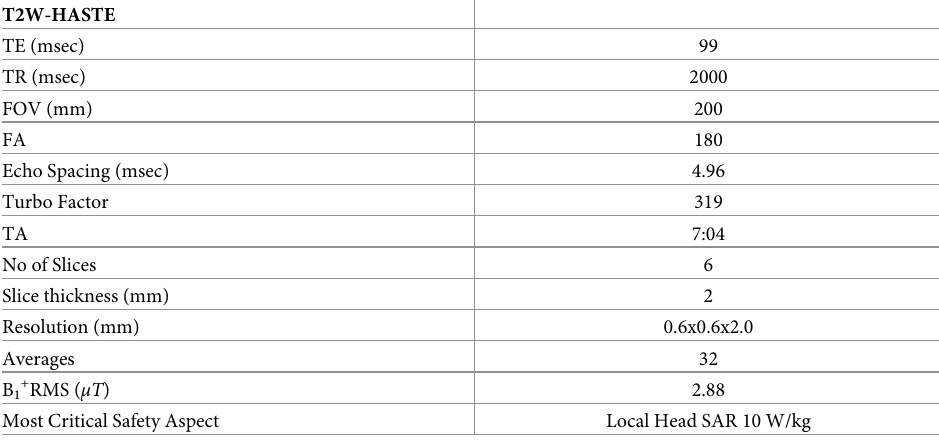
Table 1. Sequence parameters for HASTE sequence used for RF heating measurements.